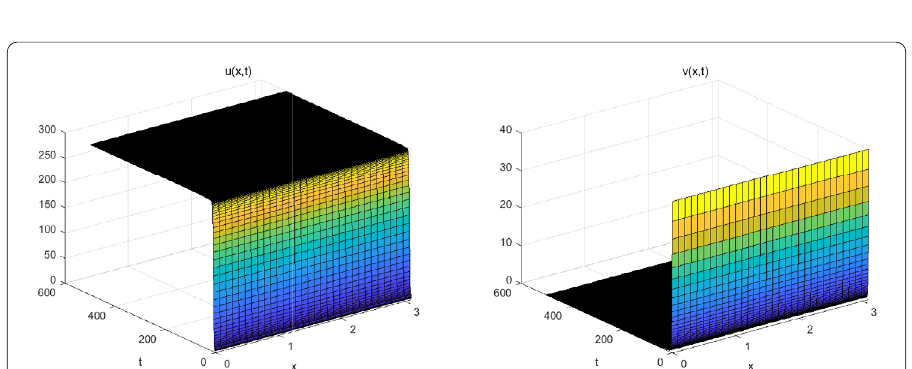
Figure 2 β = 0.9, d 1 = 1, d 2 = 0.3 and the initial condition is (10,40). P 1 = (300,0) shows global asymptotic stability